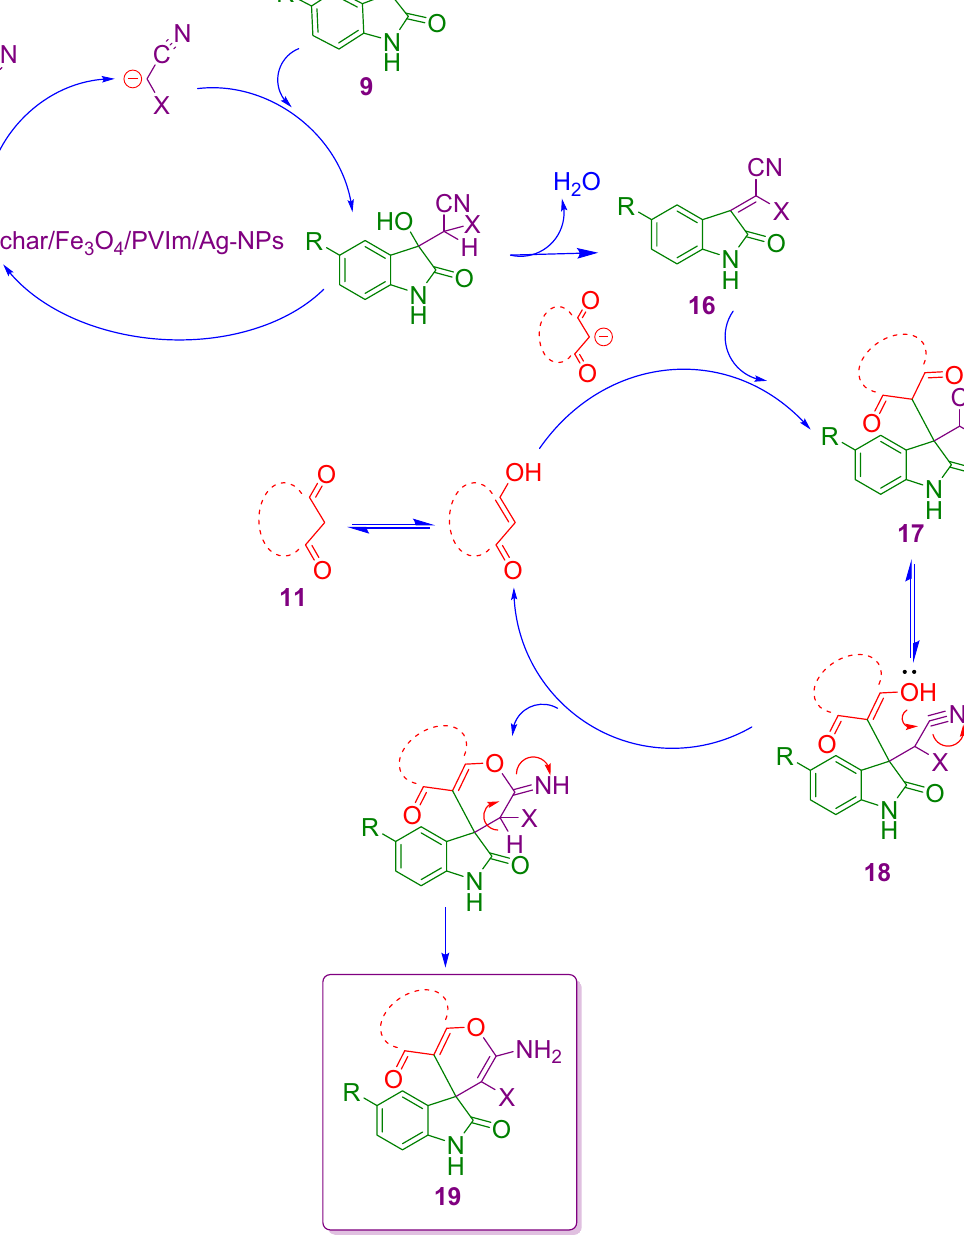
Scheme 5. Proposed component for the blend of spiro subsidiaries 19